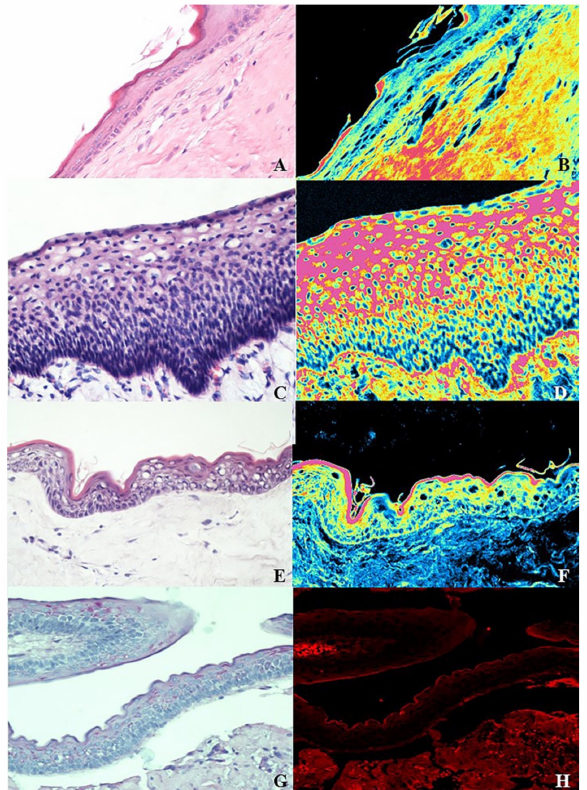
Figure 1. ( A , B ) Morphologic appearance of the epithelium in sporadic KOTs with traditional microscopy (haematoxylin–eosin staining) and the same field in Confocal Laser Scanning Mi- croscopy with a double laser inducing fluorescence (green and red) (original magnification of × 20). ( C , D ) Higher cellular density with subepithelial basophilic layers of syndromic KOTs in traditional microscopy (haematoxylin–eosin staining) and the same field in Confocal Laser Scanning Microscopy with a double laser inducing fluorescence (green and red) (original magnification of × 20). ( E , F ) Low cellular density without subepithelial basophilic layers of sporadic KOTs in traditional microscopy (haematoxylin–eosin staining) and the same field in Confocal Laser Scanning Microscopy with a double laser inducing fluorescence (green and red) (original magnification of × 20). ( G , H ) Epithelial detachment in syndromic KOTs due to the amorphous and fragile basement membrane in traditional microscopy (haematoxylin–eosin staining) and the same field in Confocal Laser Scanning Microscopy with a red laser inducing fluorescence (original magnification of ×